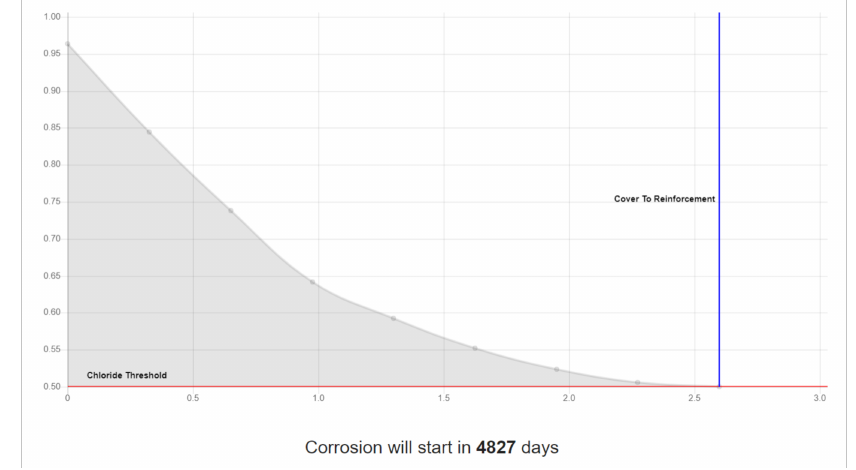
Figure 12. Typical modeling results of chloride profile and duration to corrosion